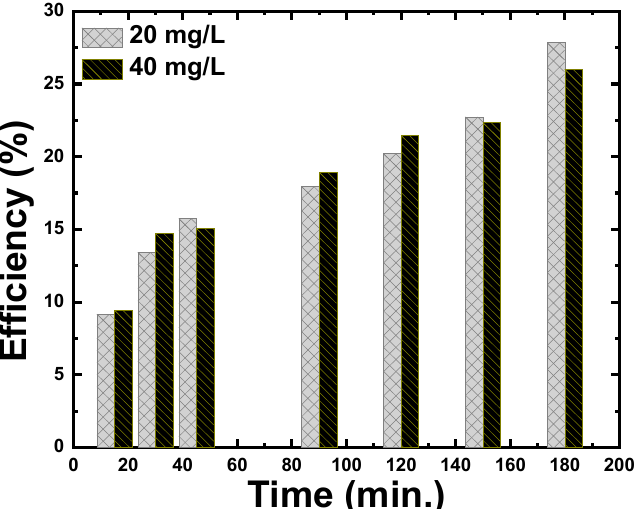
Figure 3. UV–visible absorption spectra of the ZnS nanoparticles for ( a ) 20 mg/L CR and ( b ) 40 mg/L CR dye at different shaking times. The inserted arrow shows the direction of the increase of shaking time.